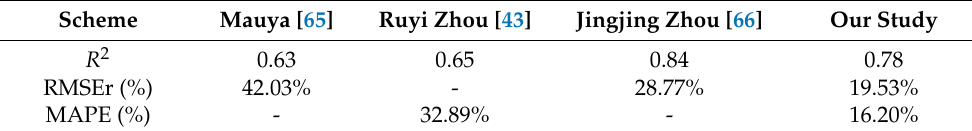
Table 6. Comparison